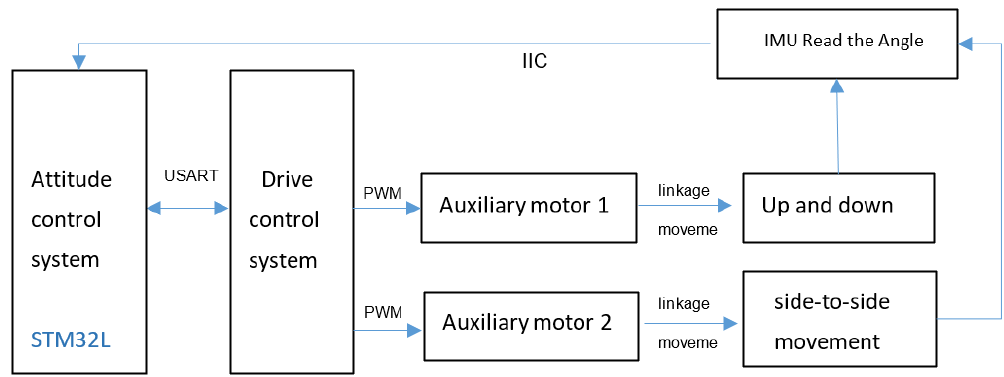
Figure 2. Principle diagram of bionic eye attitude control.